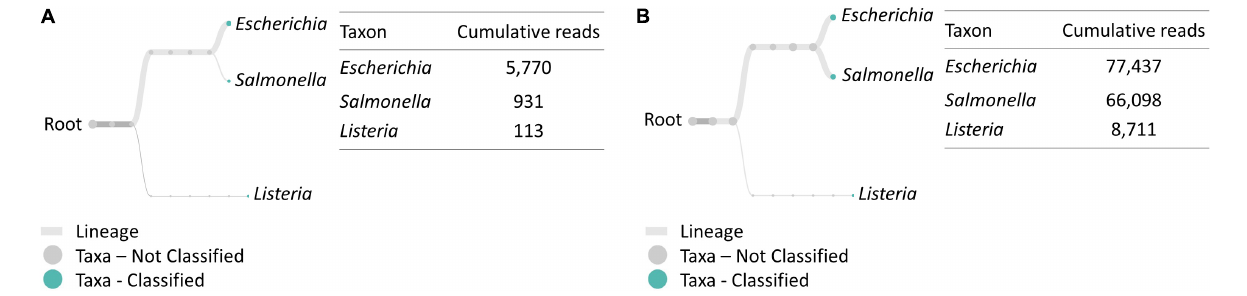
FIGURE 3 | Taxonomic and genus level bacterial classification of MinION R9.4 Rev D multiplex RT-PCR amplicon sequencing. (A) Taxonomy tree of BHI 334 4-h sample generated by EPI2ME. (B) Taxonomy tree of LJE 334 4-h sample generated by